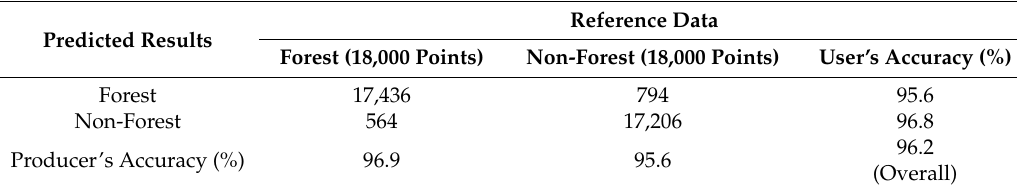
Table 3. Confusion matrix of the MCD12Q1 product-based forests and non-forests cover